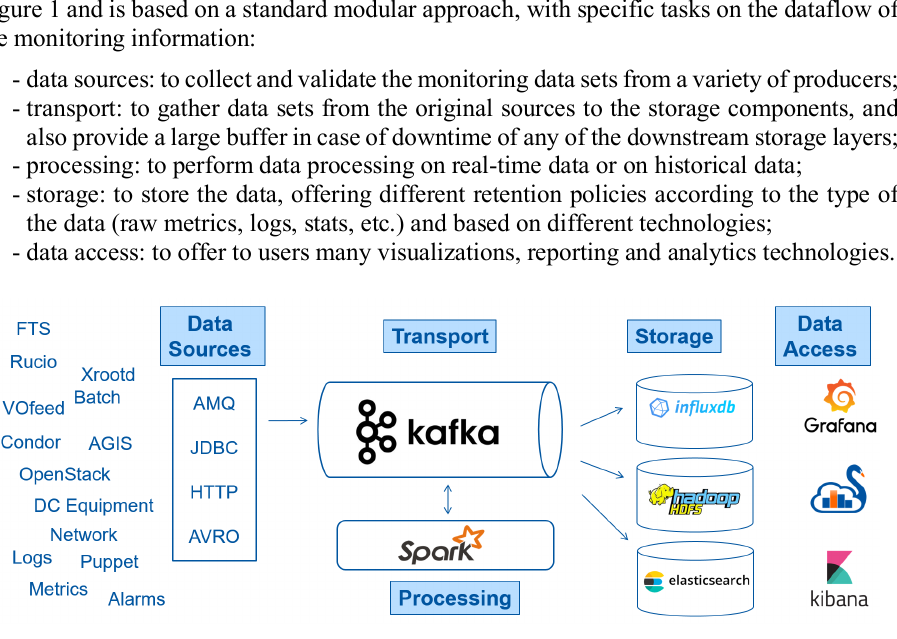
Fig. 1. MONIT Architecture and